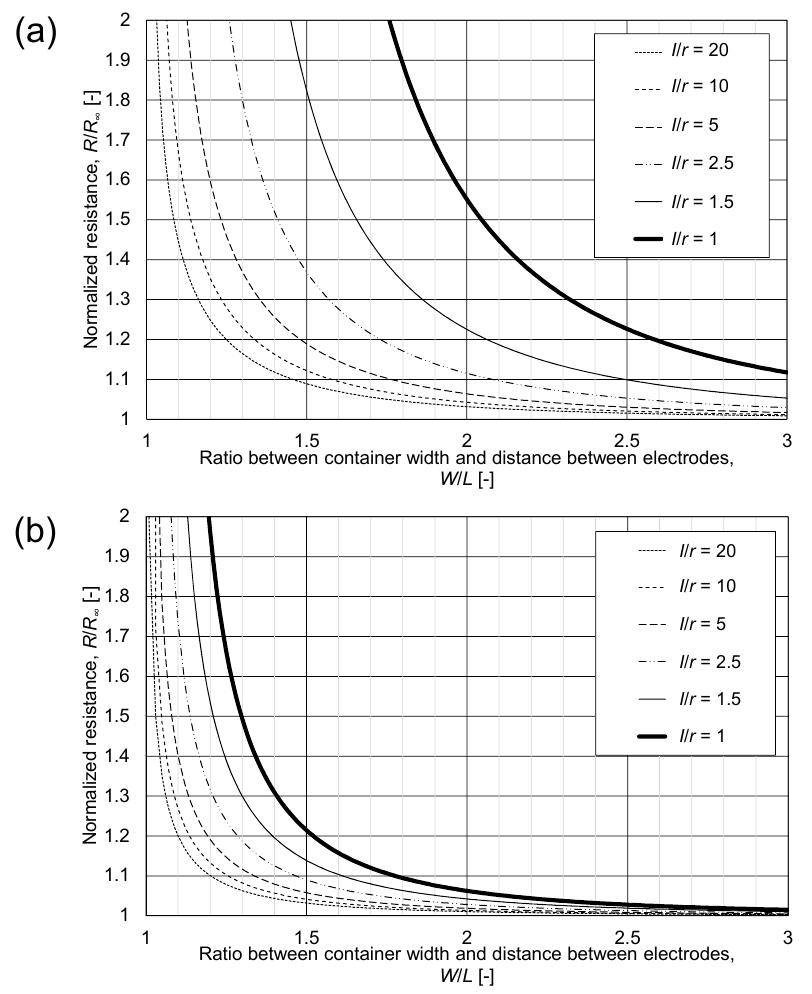
Figure 8. Variation of normalized resistance with respect to electrode geometries and container size: ( a ) L / l =3 and ( b ) L / l =10. Lines are obtained from Equation (13). Table 2. Parametric study ( r is the radius of the cylindrical electrodes, l is the penetrated depth of the cylindrical electrodes, L is the distance between two cylindrical electrodes).